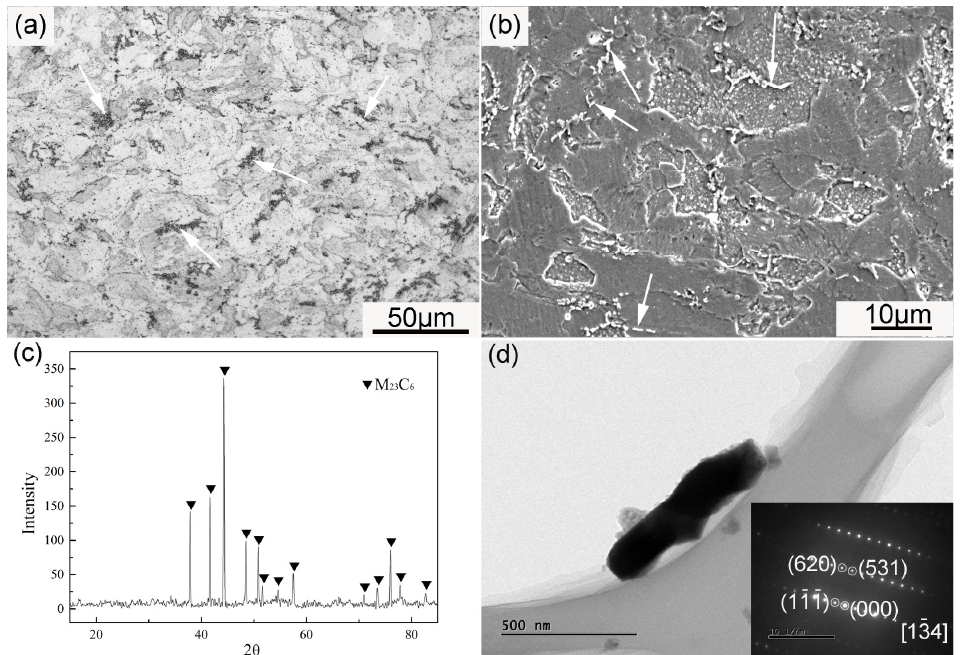
Figure 6. ( a ) OM and ( b ) SEM images of the ODS sample, ( c ) XRD pattern of the residues extracted from the sample, ( d ) TEM image of a large extracted particle and the corresponding SAD pattern. Arrows in ( a ) and ( b ) show the distribution of M 23 C 6 particles.